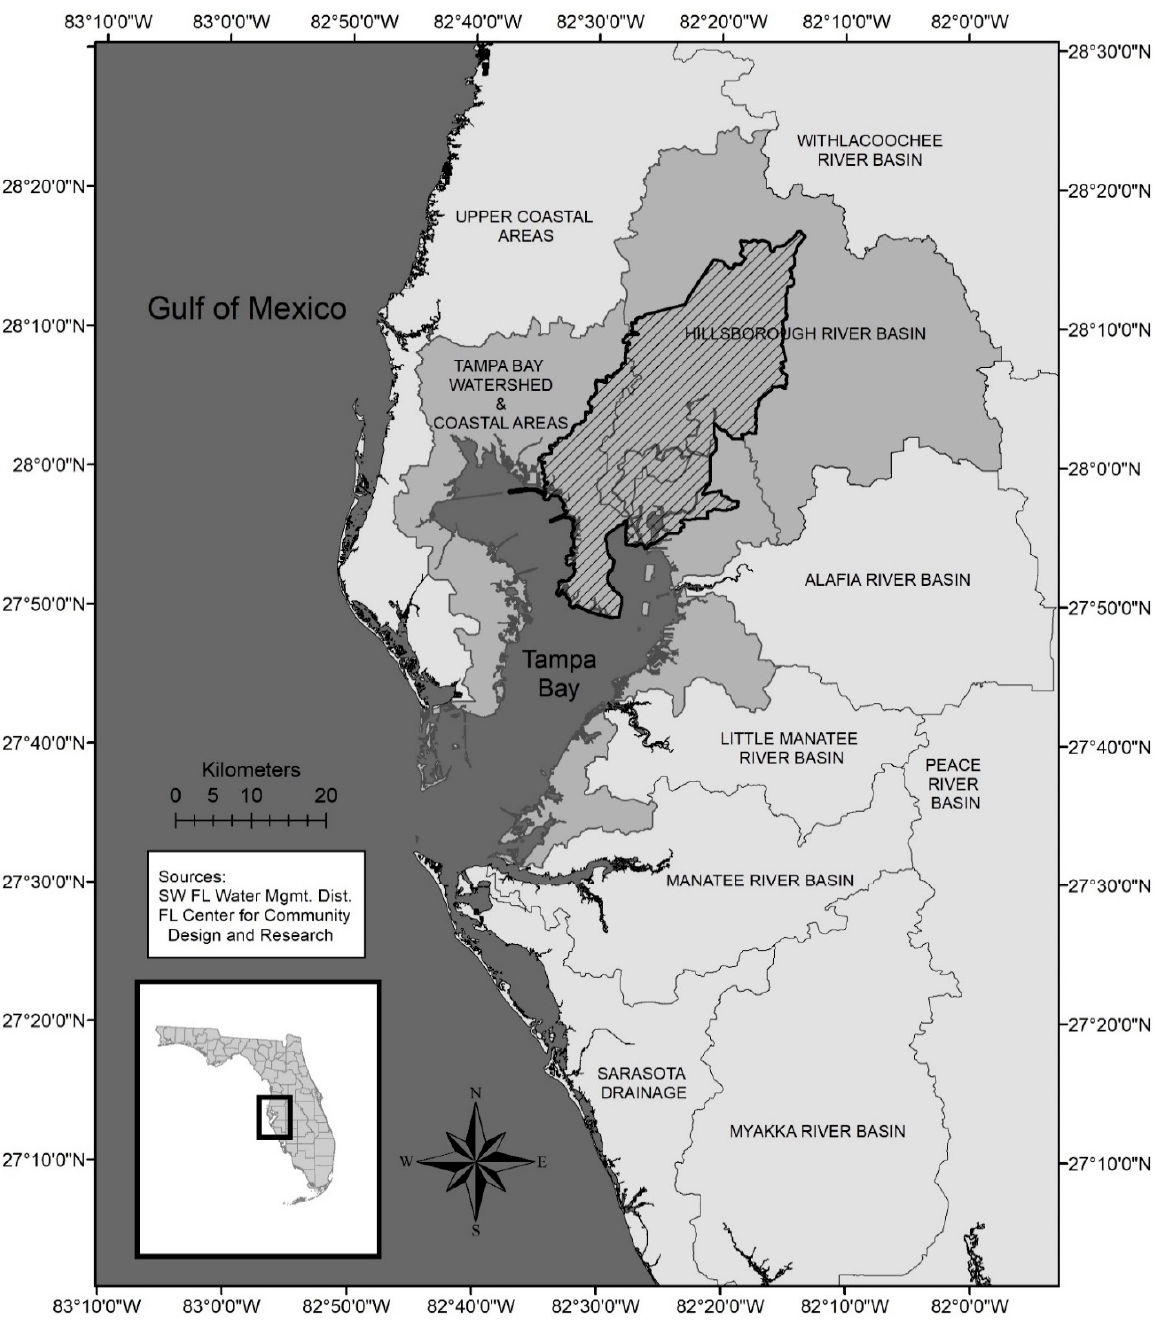
Figure 1. The Tampa Bay Watershed in west-central Florida according to the Southwest Florida Water Management District. The hatched region shows the study area within the larger